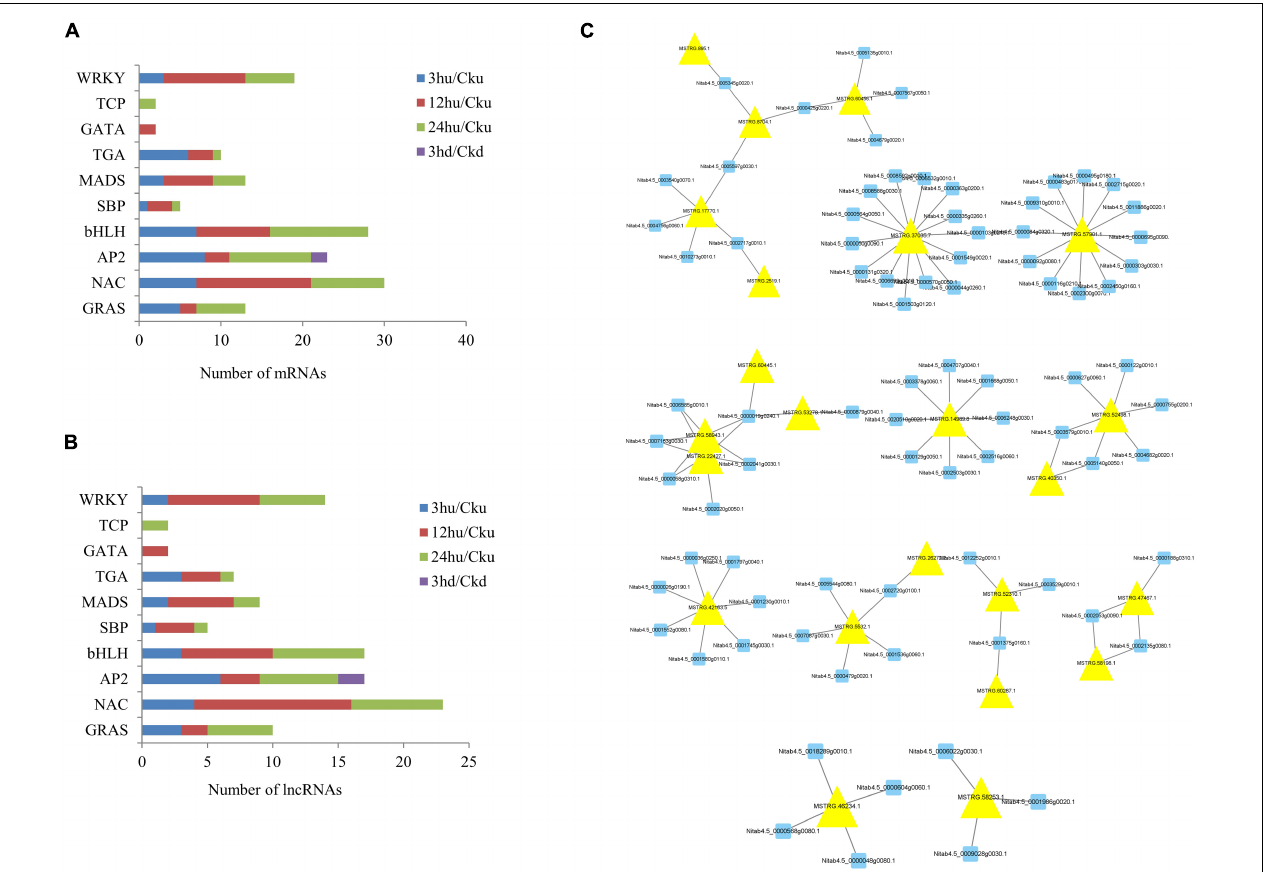
FIGURE 6 | Distribution of transcription factor gene families and their co-expressed lncRNAs in the four treatments (3 hu, 12 hu, 24 hu, and 3 hd vs. the respective controls). (A) Distribution of transcription factors in all four treatments. (B) Distribution of lncRNAs co-expressed with transcription factors in all four treatments. (C) mRNA-lncRNA interaction networks of transcription factors and their co-expressed lncRNAs. Blue nodes represent mRNAs, and yellow nodes represent lncRNAs.